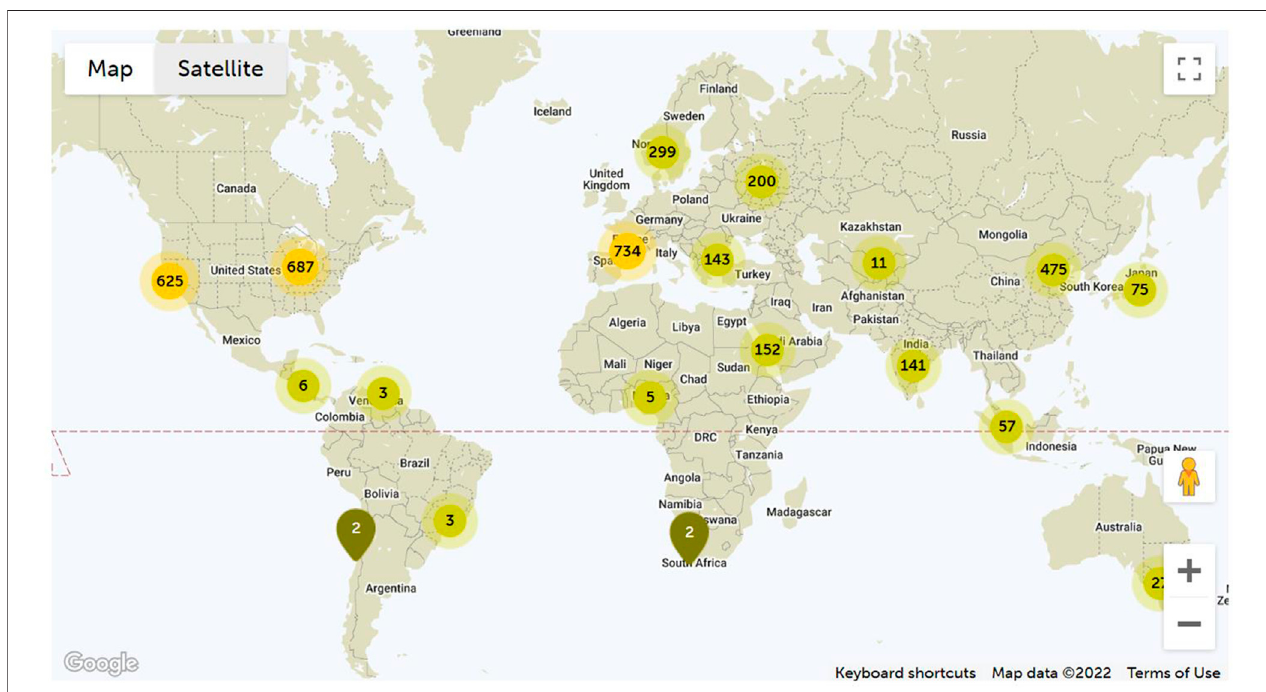
FIGURE 1 | Research topic demographics